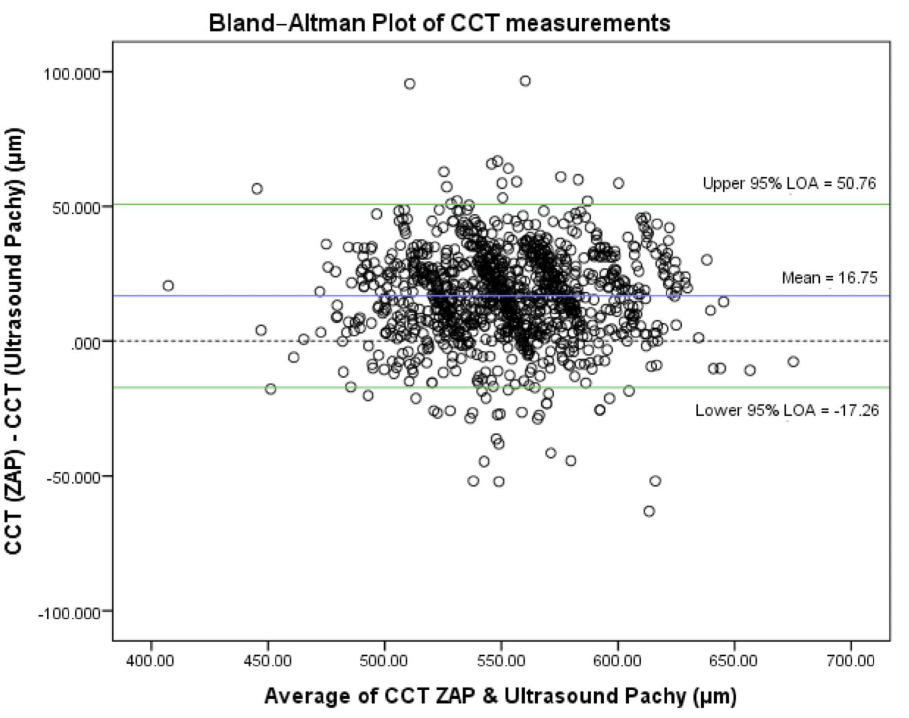
Figure 2. Bland-Altman plot of central corneal thickness (CCT) measurements, with zero-line (blue line), mean difference (red line) and 95% limits of agreement (green dotted lines), comparing AS-OCT (ZAP) and Ultrasound Pachymetry. X-axis units= m m/Y-axis units= m m.